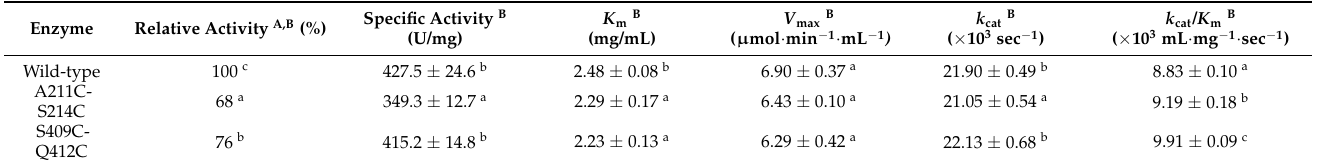
Table 2. Activities and kinetic parameters for mutants compared to wild-type MFA ps on maltodextrin (DE = 4) at 50 ◦ C.